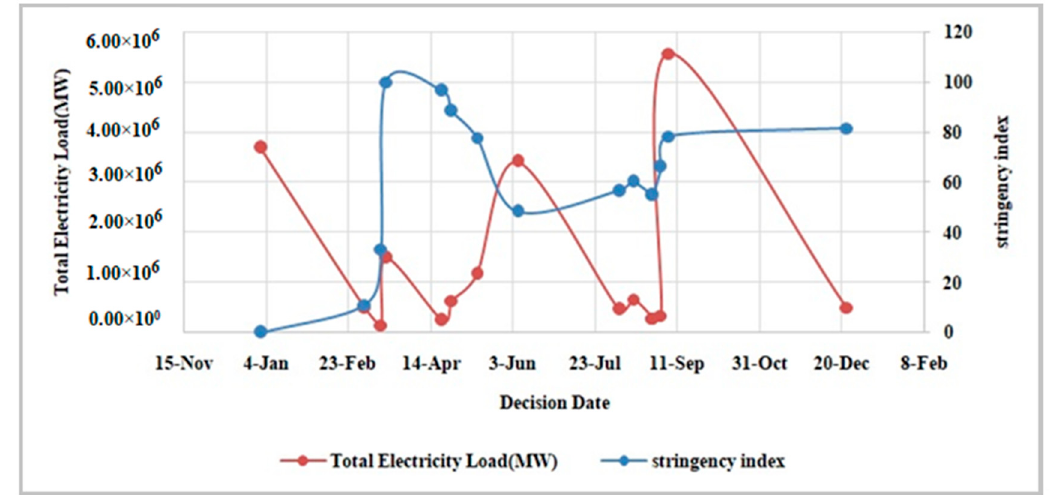
Figure 6. Change in electricity load by the critical decision date for 2020.